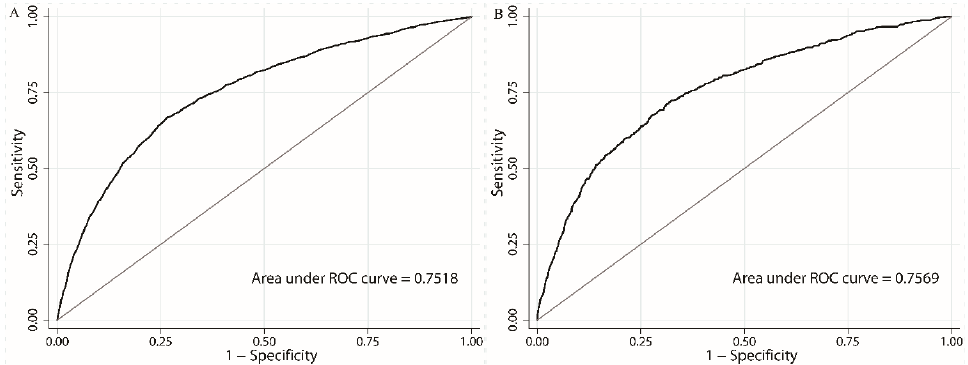
Figure 2. Discrimination plots in the ( A ) development and ( B ) validation datasets.